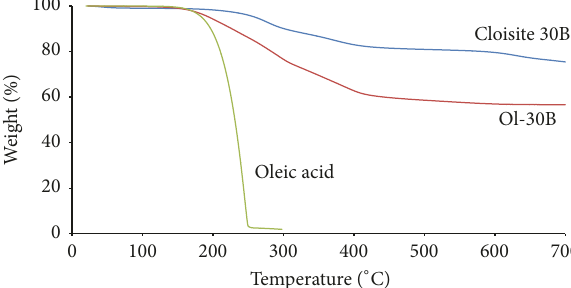
Figure 3: XRD results of MMT and ol-MMT.